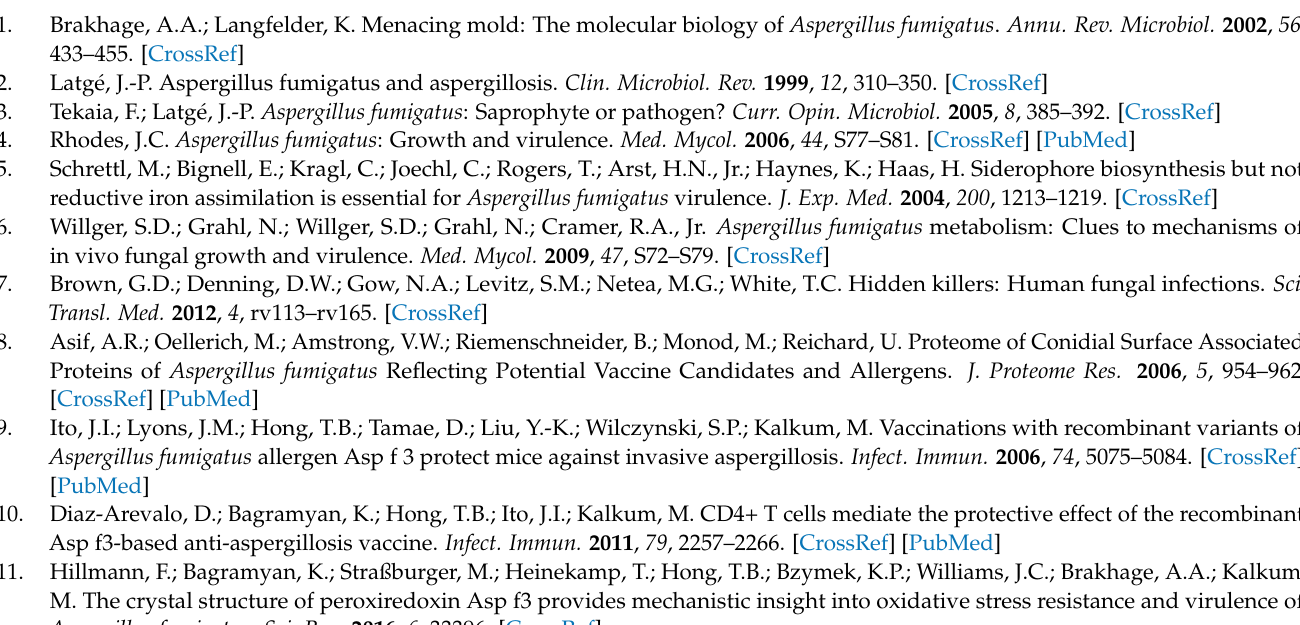
for comparison. Table S1: Primer list for the generation of Afyap1 VENUS . Table S2: Results of the gene enrichment analysis (GO-term search, molecular function). Table S3: Results of the gene enrichment analysis (GO-term search, biological